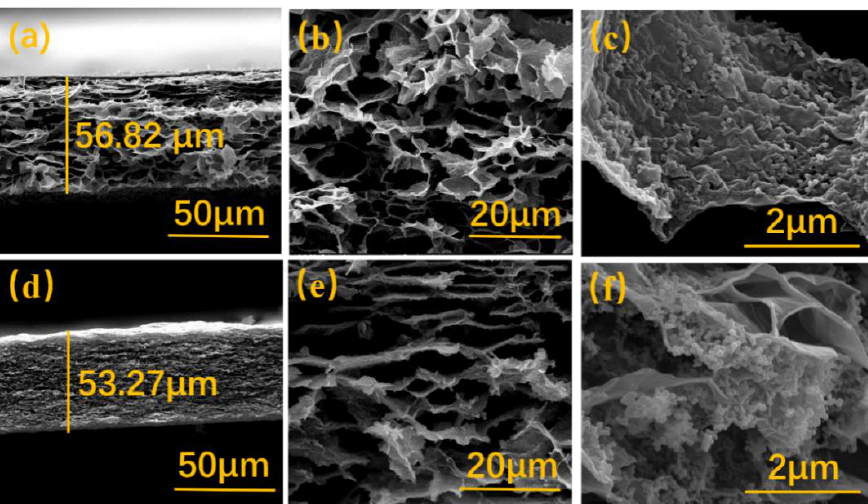
Figure 4. ( a – c ) Cross-sectional scanning electron microscope (SEM) images of C@Si/rGO film, and ( d